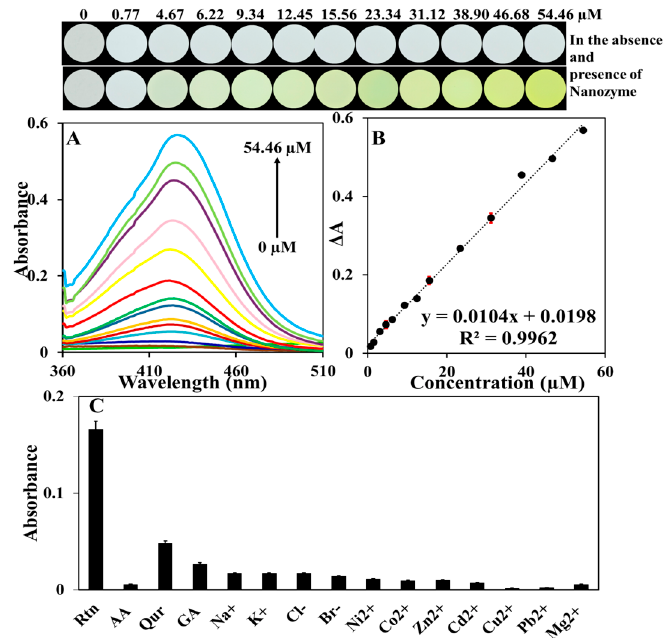
Figure 4. ( A ) UV–Vis spectra of different concentrations of Rtn including 0, 0.77, 1.56, 3.11, 4.67, 6.22, 9.34, 12.45, 15.56, 23.34, 31.12, 38.9, 46.68, and 54.46 µM in the presence of Cu-Guo NRs nanozyme under optimum condition (from bottom to top). ( B ) Calibration curve resulting from the change of the absorbance signal ( Δ A) vs. different concentrations of Rtn with low error bar values, along with the recorded images for different concentration of Rtn in the presence and absence of nanozyme. ( C ) The absorbance spectra of the sensor response in the presence of common interfering species such as Qur (33.08 µ M), AA (567.79 µ M), and GA (235.13 µ M) and various ions including K + (2.558 mM), Na + (4.349 mM), Cl − (2.820 mM), Br − (1.251 mM), Ni 2 + (1.703 mM), Co 2 + (1.696 mM), Zn 2 + (1.529